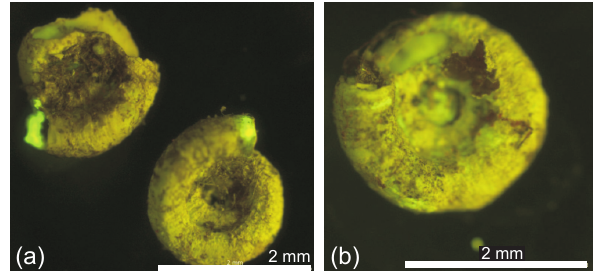
Figure 16. Strongly bio-eroded and broken S. spirorbis tubes from summer + T experiment ( a : basin A2; b : basin C2). Tubes are partly covered by filamentous algae. Note spongy appearance of tubes due to intense microboring. Stain lines indicating the start of the experi- ment are visible at the tube mouths in the left picture. Scale bars are